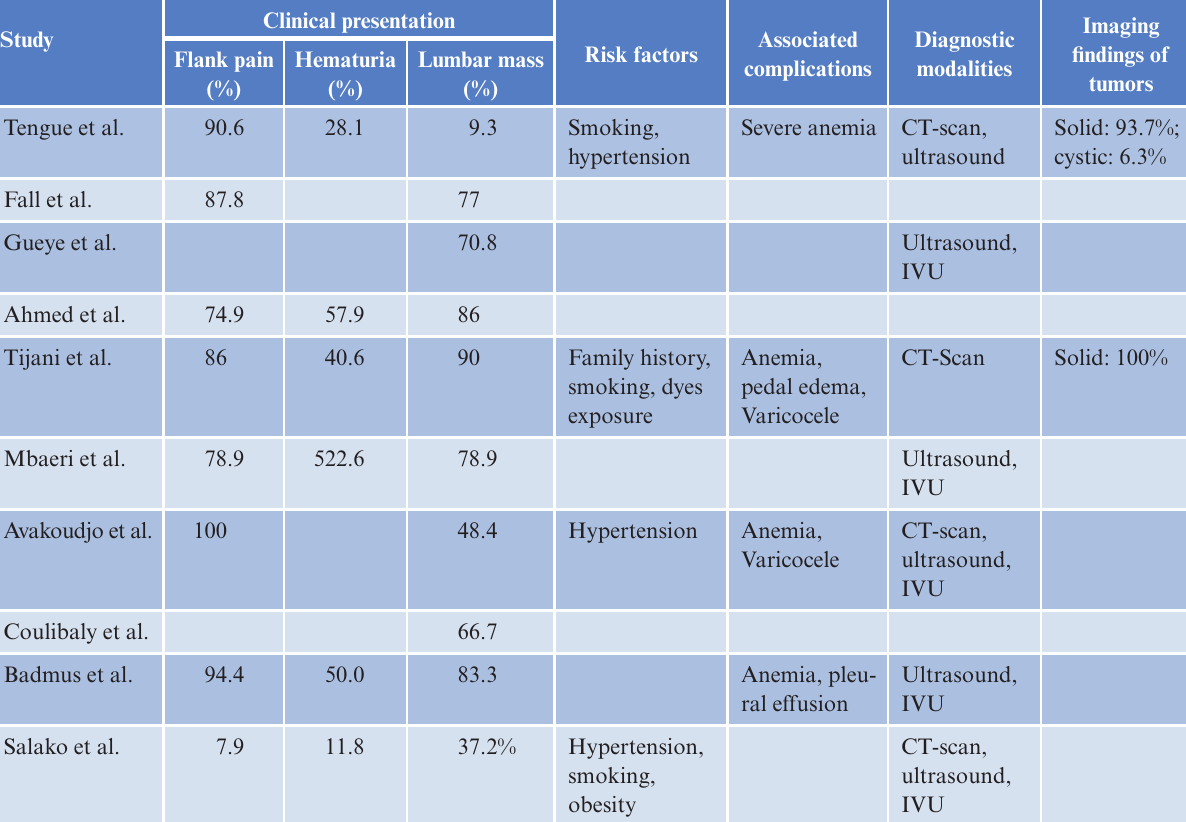
Table 2: Clinical manifestation, risk factors, complications, and diagnostics modalities of renal cell carcinoma Clinical Study